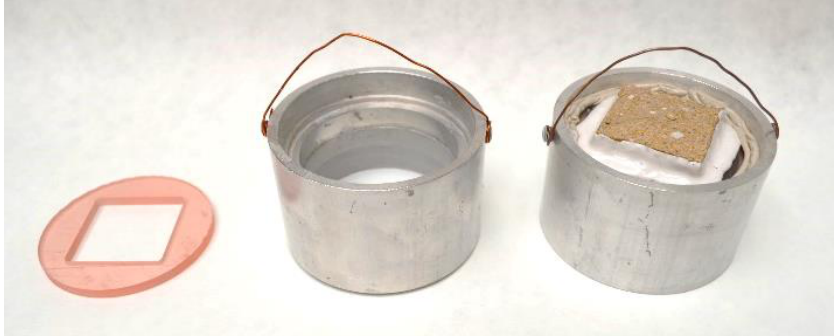
Figure 35. Arrangement of the water vapour permeability test.